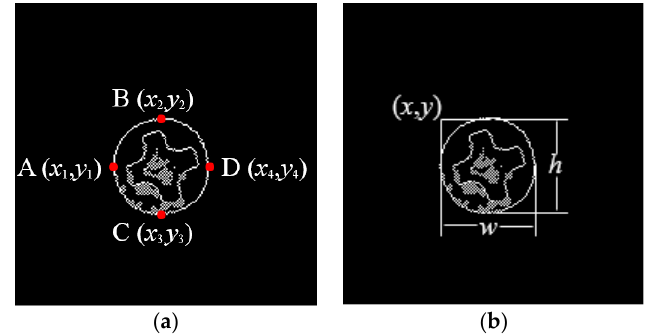
Figure 12. Screw surface localization. ( a ) Boundary points, ( b ) Located screw surface area.